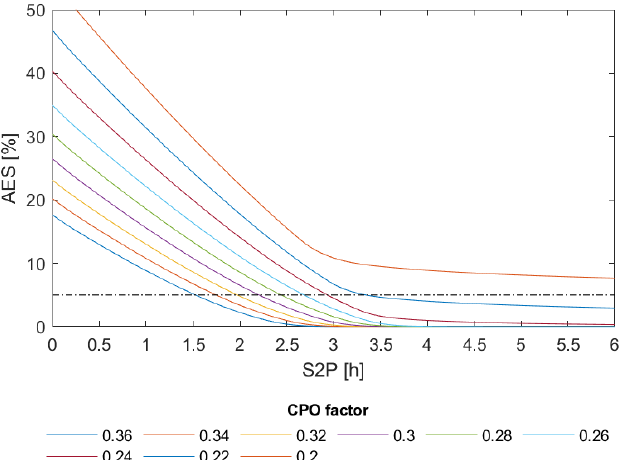
Figure 5. AED according to the S2P and CPO factors for the annual constant power setpoint (ACPS).